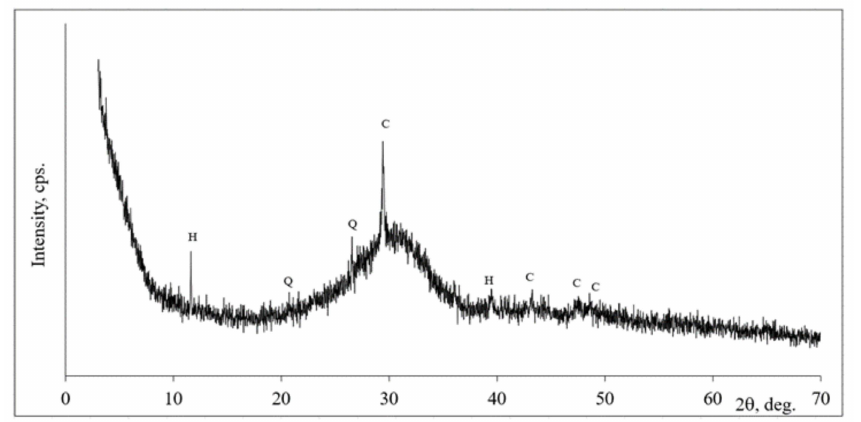
Figure 1. The X-ray diffraction patterns of